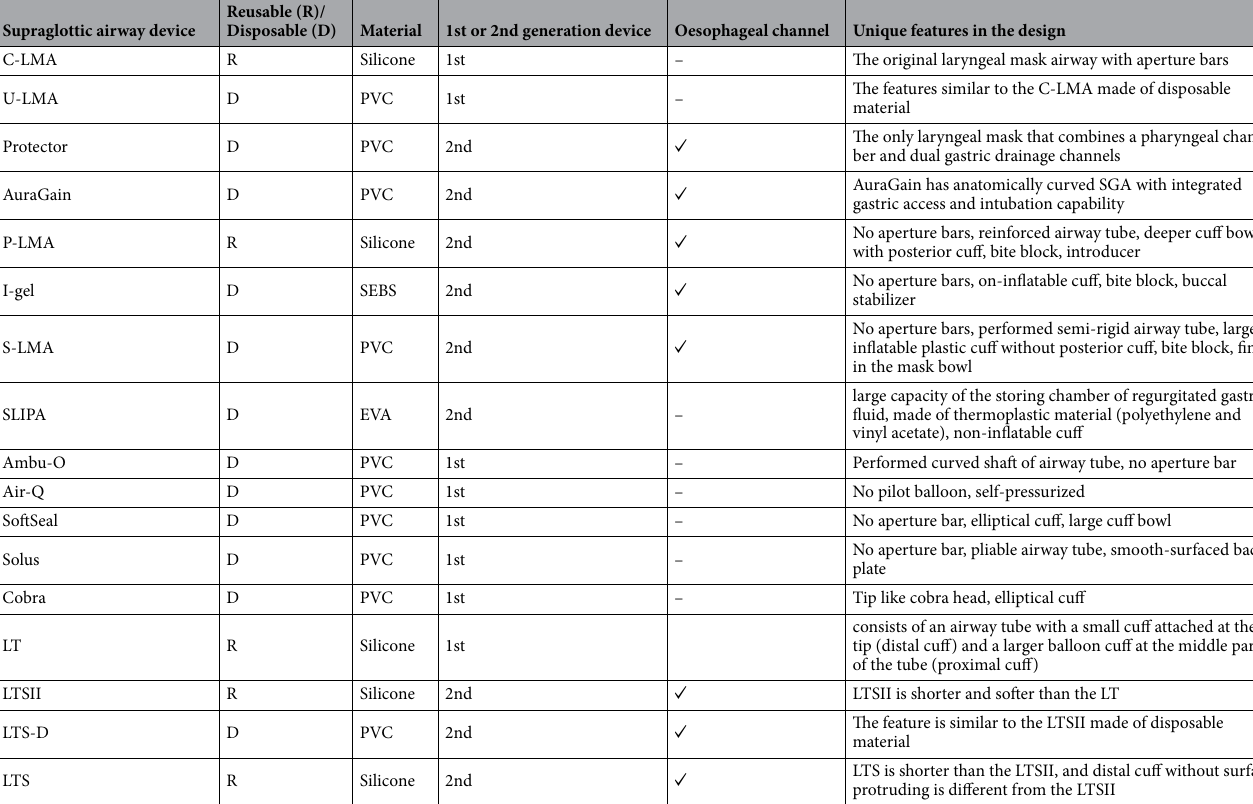
Table 1. The characteristics of supraglottic airway devices. PVC: polyvinyl chloride; SEBS, Styrene Ethylene Butylene Styrene; EVA, ethylene vinyl-acetate copolymer; C-LMA, LMA Classic; U-LMA, Unique LMA; Protector, LMA Protector Airway; AuraGain, Ambu AuraGain Disposable Laryngeal Mask; P-LMA, Proseal LMA; I-gel, I-gel supraglottic airway; S-LMA, Supreme LMA; SLIPA, Streamlined Liner of the Pharynx Airway; Ambu-O, Ambu AuraOnce; Air-Q, Air-Q Masked Laryngeal Airway.; SoftSeal, The Portex Soft Seal Laryngeal Mask; Solus, Solus Standard Laryngeal Mask Airway; Cobra, Cobra Perilaryngeal Airway; LT, Laryngeal Tube; LTSII, Laryngeal Tube Suction II; LTS-D, Laryngeal Tube Disposable; LTS, Laryngeal Tube